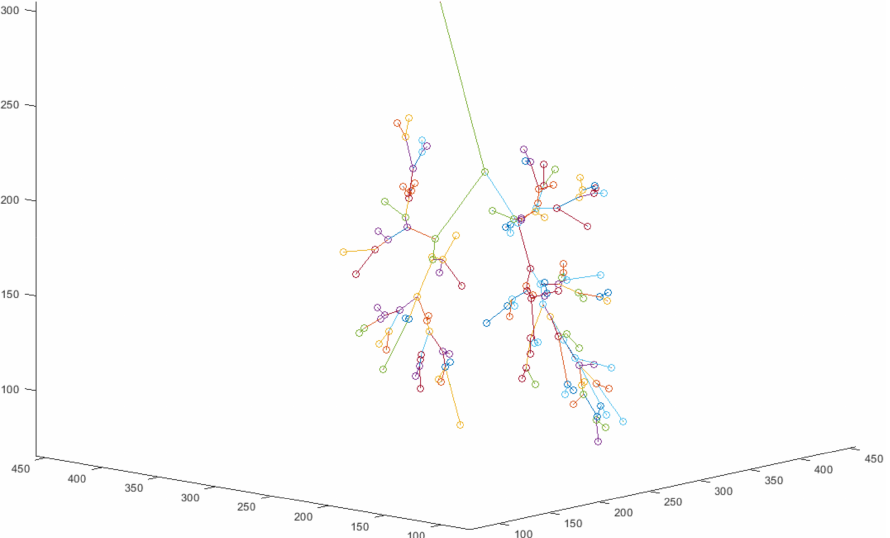
Figure 9. Visual tree